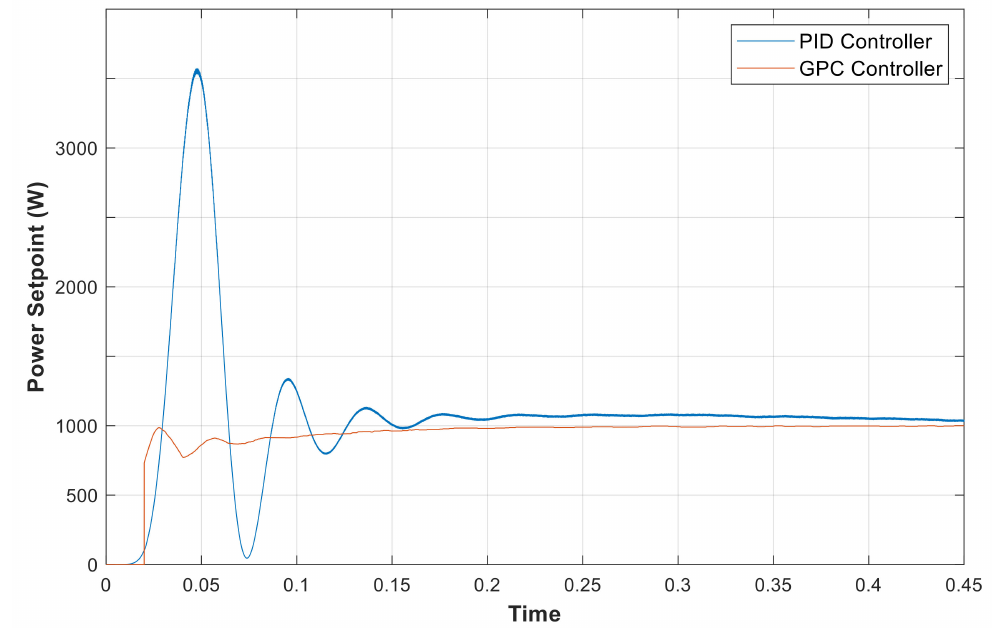
Figure 15. Power regulation for the GPC and PID